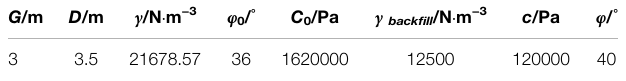
TABLE 8 | Physical and mechanical parameters of the Antaibao open-pit11 # coal obtained after average calculation and